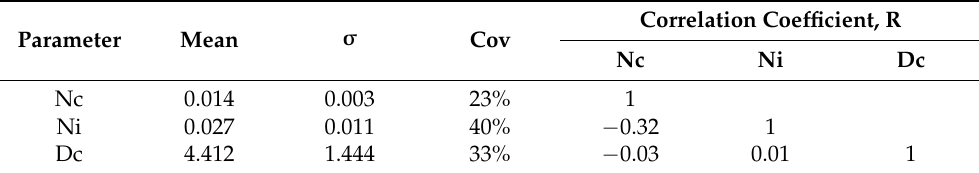
distributions for the parameters.